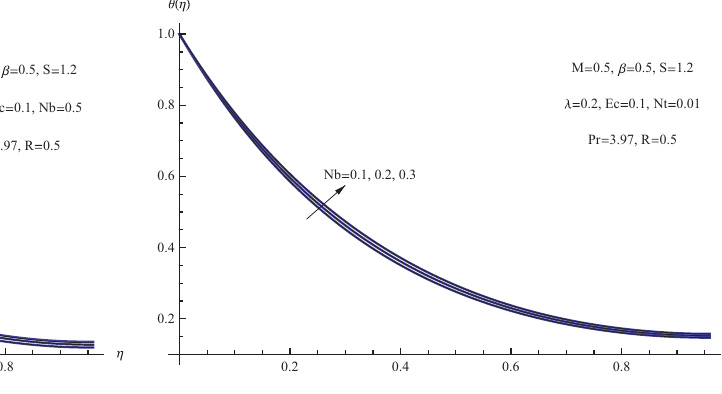
Figure 18: ( ) θ η for assorted quantities of Nb.